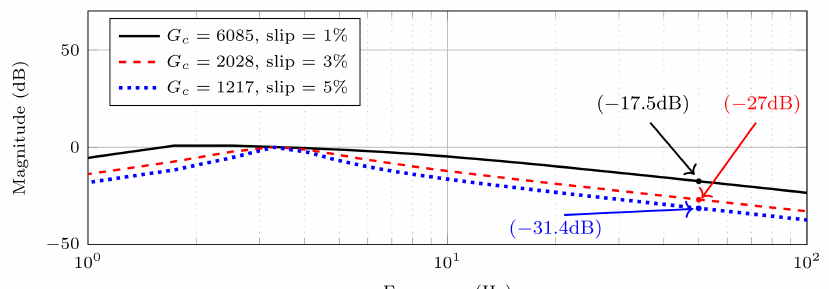
Figure 13. Frequency response with rated slip (and corresponding gain) a parameter. The inertia ( J m ) of the PMSG remained the same in the